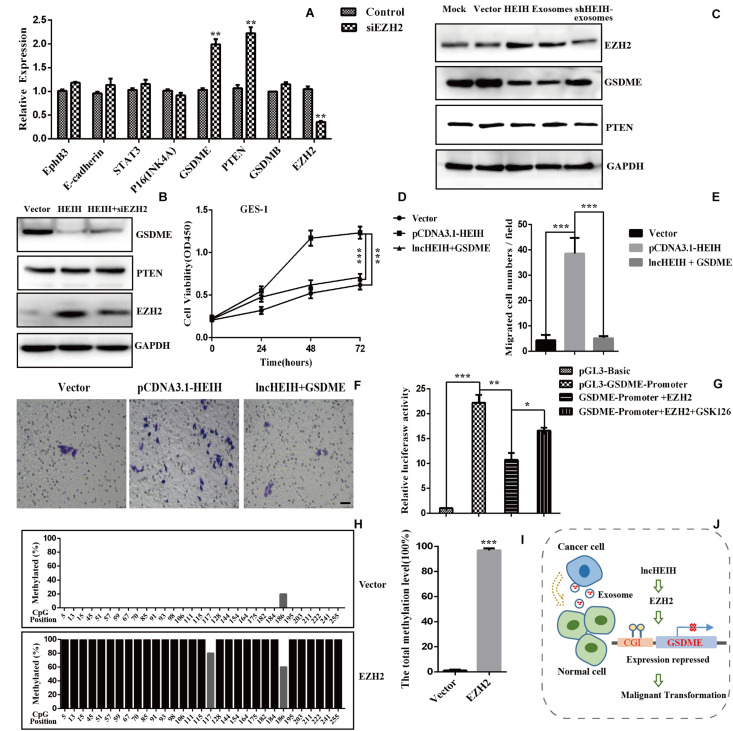
The lncHEIH-EZH2 axis promotes malignant transformation of normal gastric cells by stimulating methylation of the GSDME promoter. (A) qRT-PCR analysis was used to determine the mRNA levels of EZH2-related tumor suppressor genes when EZH2 was interfered in lncHEIH-overexpressing GES-1 cells. (B) Immunoblot analysis of GSDME and PTEN protein levels in lncHEIH-overexpressing cells transfected with siEZH2-2 for 48 h. (C) The expression levels of EZH2, GSDME and PTEN in GES-1 transfected with lncHEIH or added exosomes to the medium for 48 h. (D–F) CCK-8 and Transwell assays were used to determine the proliferation and migration of lncHEIH-overexpressing GES-1 cells transfected with GSDME (scale bars = 50 μm). (G) The promoter deactivation of GSDME caused by EZH2 was reduced when the histone methyltransferase inhibitor GSK126 was added. The results shown are the mean ± SD from three independent experiments. (H,I) Methylated bisulfite sequencing PCR analysis. GES-1 cells transfected with EZH2 expression plasmid or empty control plasmid were collected. The methylation level of the GSDME promoter CpG island was detected by bisulfite sequencing PCR. *P < 0.05, **P < 0.01, ***P < 0.001. (J) Graphical abstract showing that exosome-delivered lncHEIH promotes gastric cancer progression by upregulating EZH2 and stimulating methylation of the GSDME promoter.